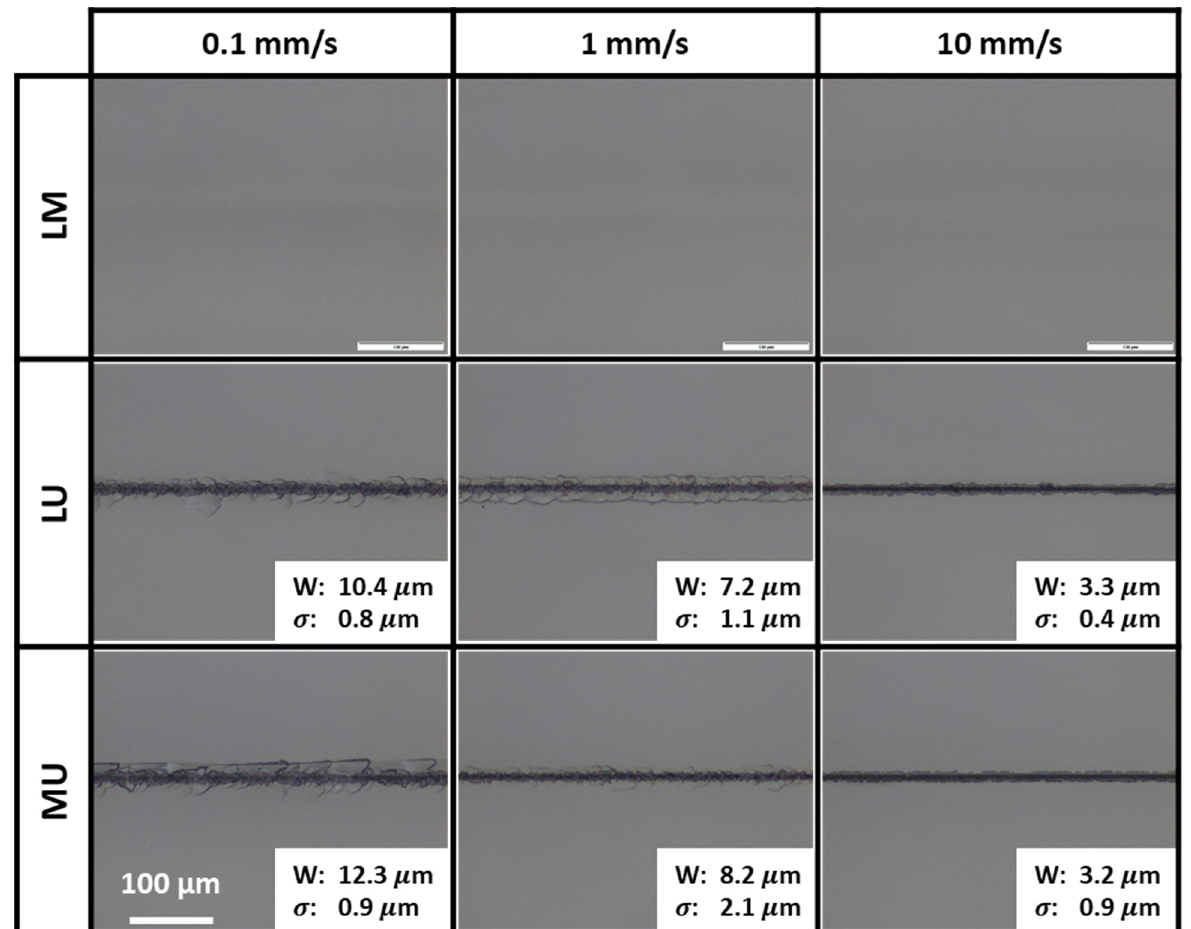
Figure 3. Top polished entry surface optical images for two-zone scanning showing top surface scribes (if any) with their widths (W) and standard deviations ( σ )